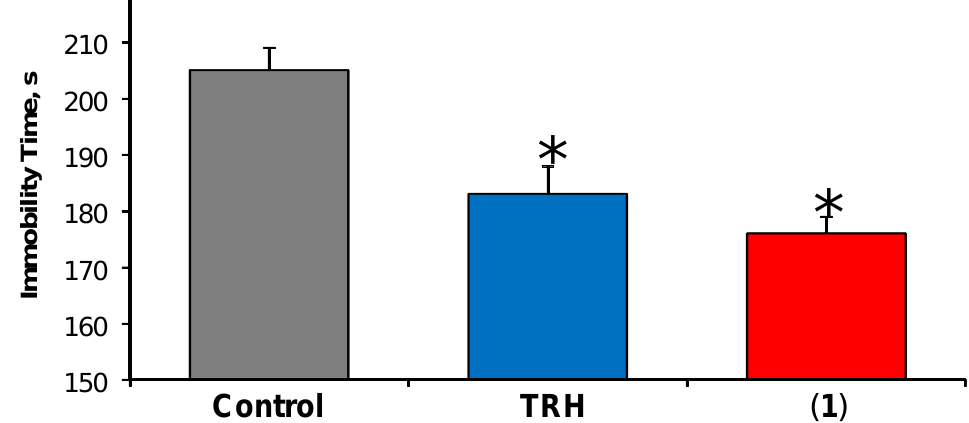
Figure 2. The antidepressant-like effect of TRH after subcutaneous (s.c.) administration of ( 1 ) at the dose of 3 µmol/kg body weight. Equimolar dose of TRH was used as a positive control. Data is expressed as average ± standard error, n = 8. Asterisks indicate statistically significant differences ( p < 0.05) from the vehicle control group using one-way ANOVA followed by post hoc Tukey test.